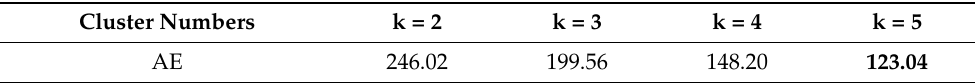
Table 4. Area error (AE) of different cluster numbers.